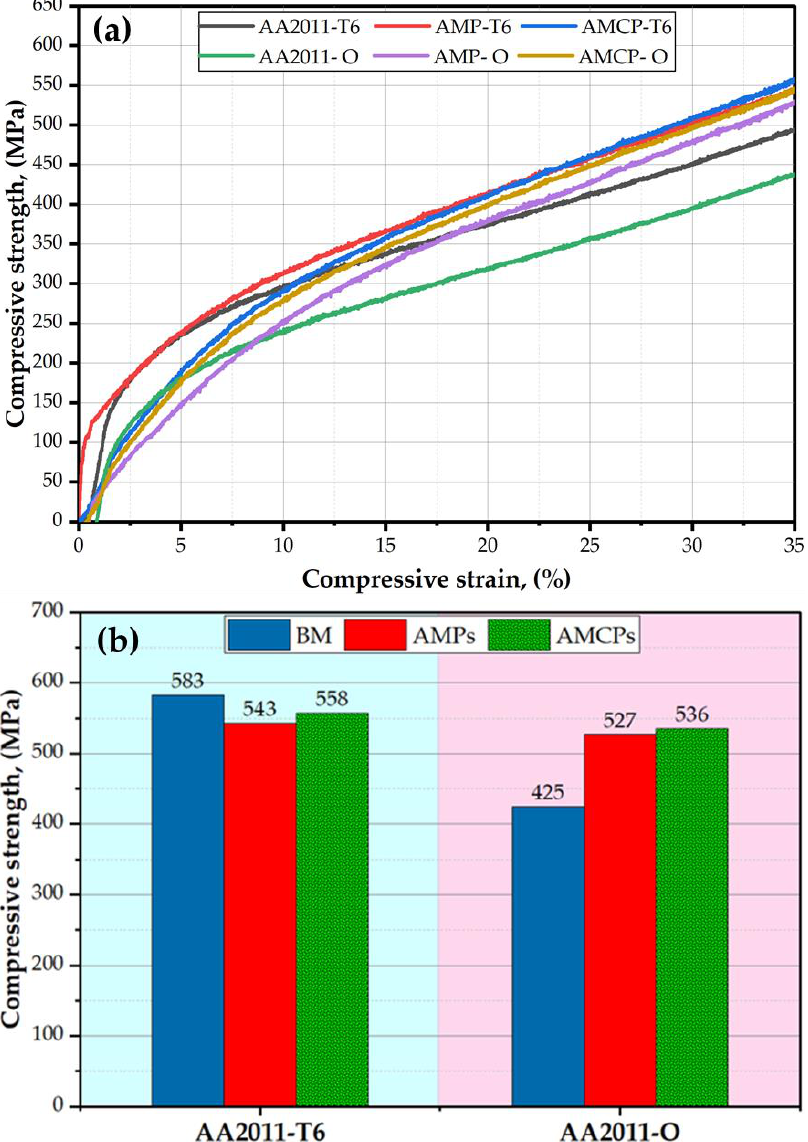
Figure 17. ( a ) Stress–strain compression curves of the initial materials, AMPs, and AMCPs for AA2011-T6 and AA2011-O; ( b ) compressive strength values at a strain of 35% for the initial materials, AMPs, and AMCPs at both temper conditions of T6 and O.